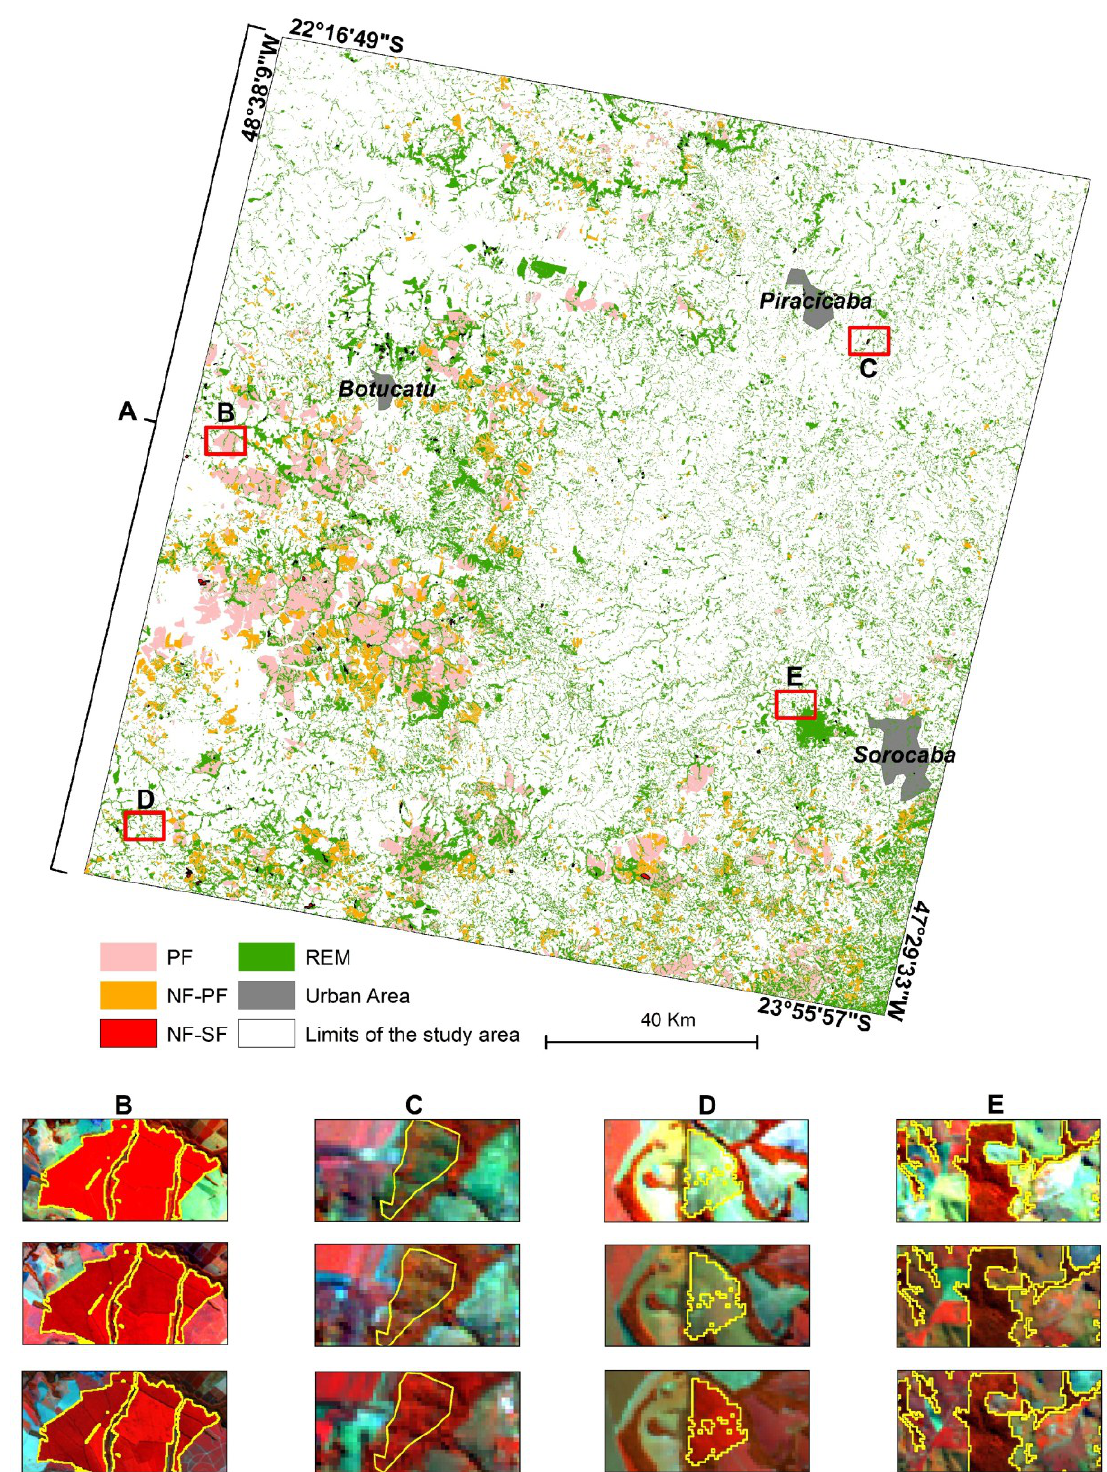
Figure 4. In ( A ) forest cover transitions map for the 2006–2013 period, with example of: ( B ) planted forest (PF); ( C ) non-forest to secondary forest (NF-SF); ( D ) non-forest to planted forest (NF-PF); and ( E ) remnants (REM). ( B – E ) show false color RGB 453 of a Landsat TM images for 2006 and 2009 and RGB 564 of a Landsat OLI of 2013.